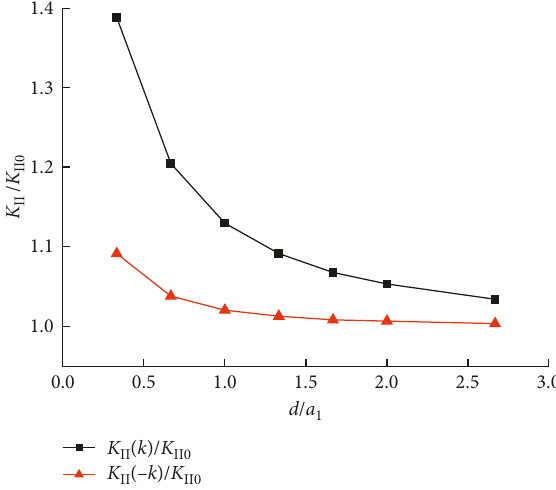
Figure 3: Relation of the normalized SIF and d/a